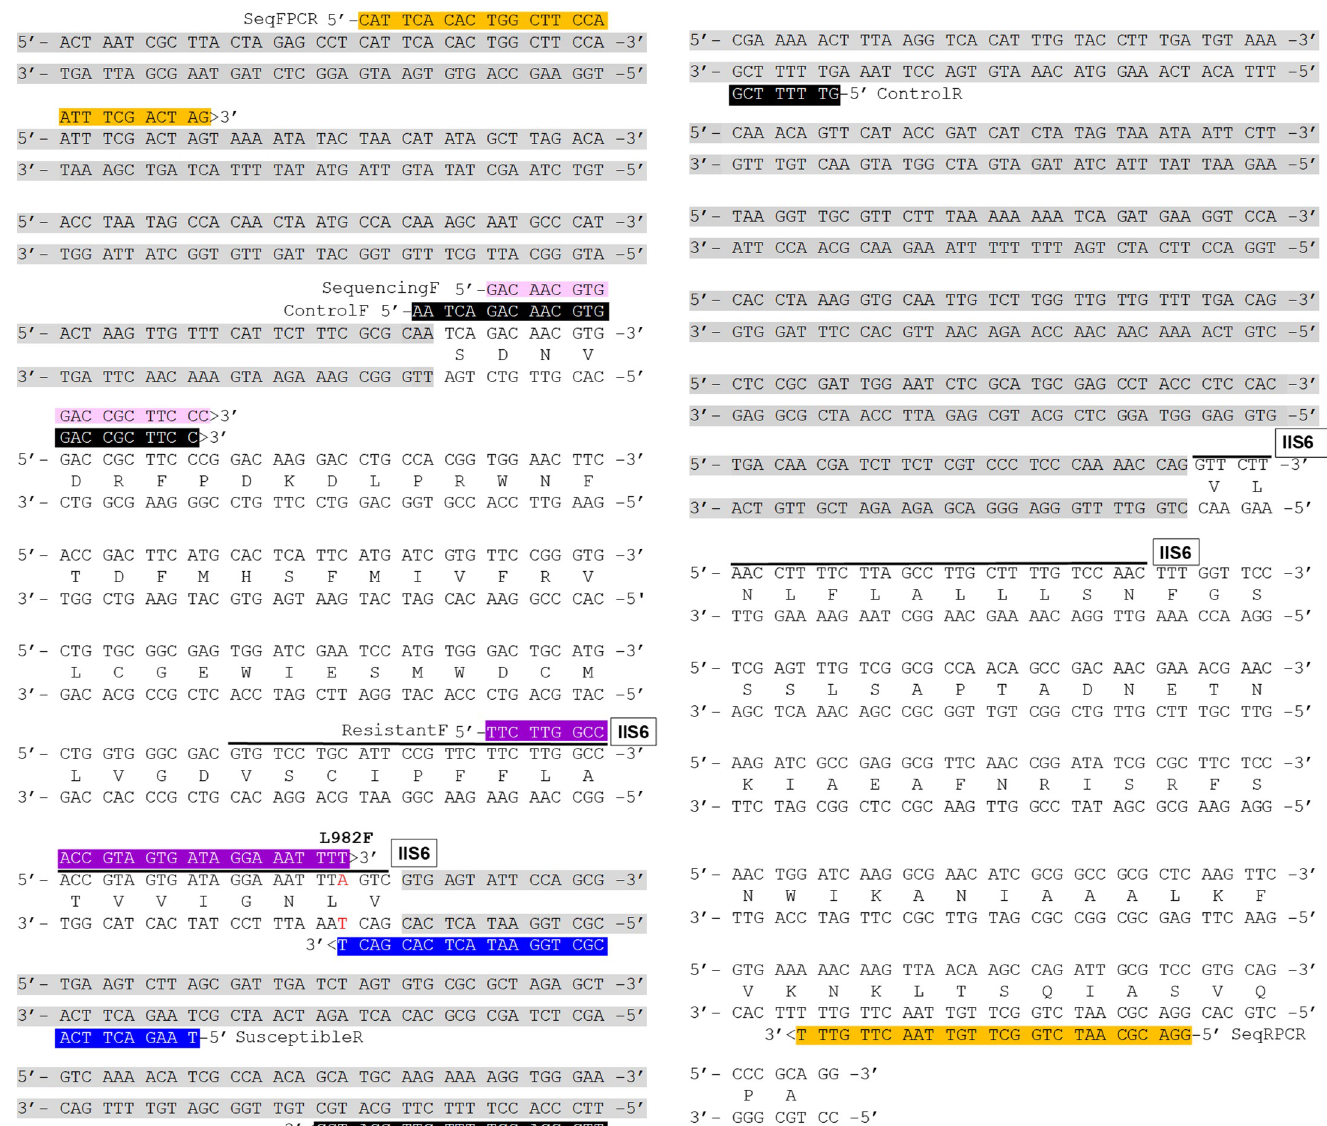
Fig 5. Partial Na v channel sequence with primers for kdr -like diagnostic PCR, partial Na v amplification, and sequencing. Intronic regions are in gray. The primer set of diagnostic PCR: control primers (ControlF and ControlR) are boxed in black; the diagnostic resistant primer (ResistantF) is in purple; the diagnostic susceptible primer (SusceptibleR) is in blue. Primers (SeqFPCR and SeqRPCR) for generating an 850 bp PCR product for sequencing are in orange; the primer utilized for sequencing (SequencingF) is in